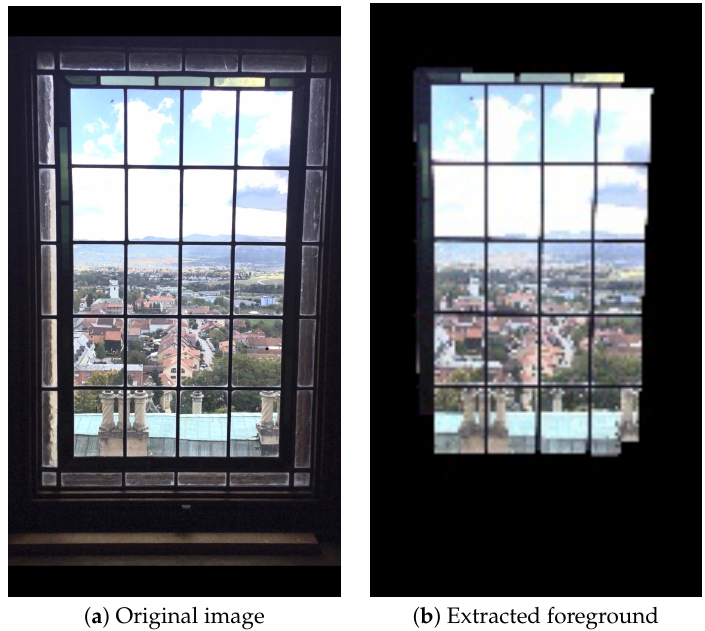
Figure 36. The result of extracting the foreground in a frame-within-a-frame composition method when a closed frame is encountered.